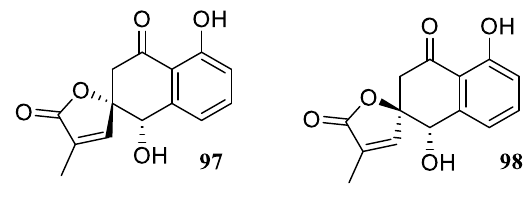
Figure 42. Lambertollols A and B.